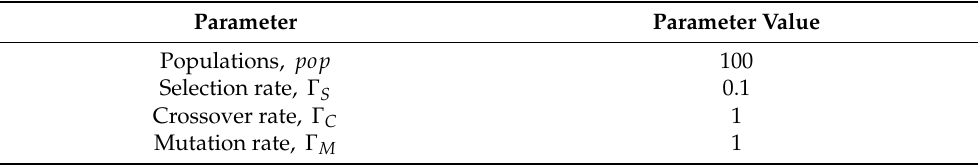
Table 3. Listing of related parameters in the